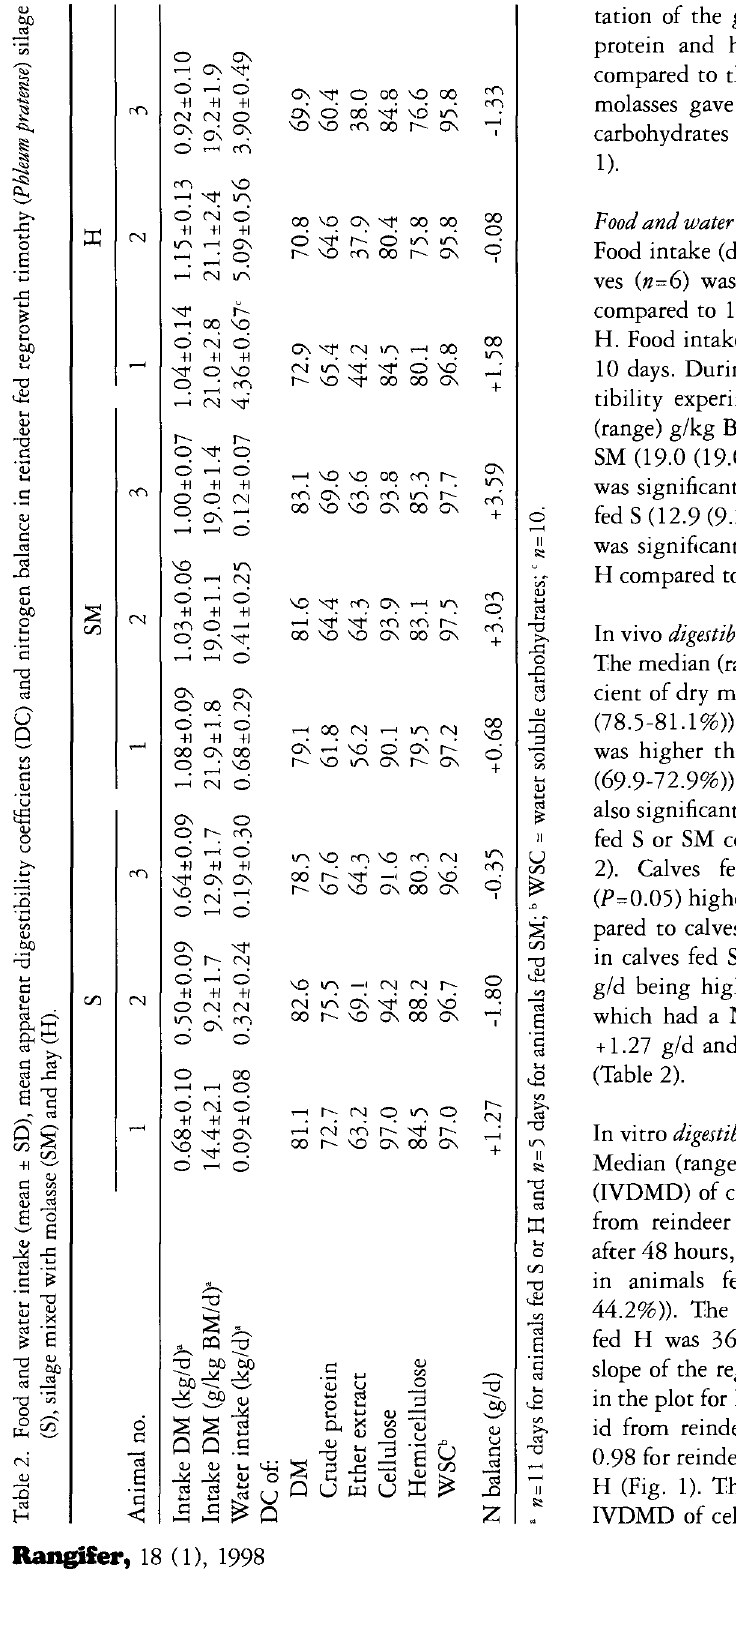
(Table 2). In vitro digestiblity of cellulose